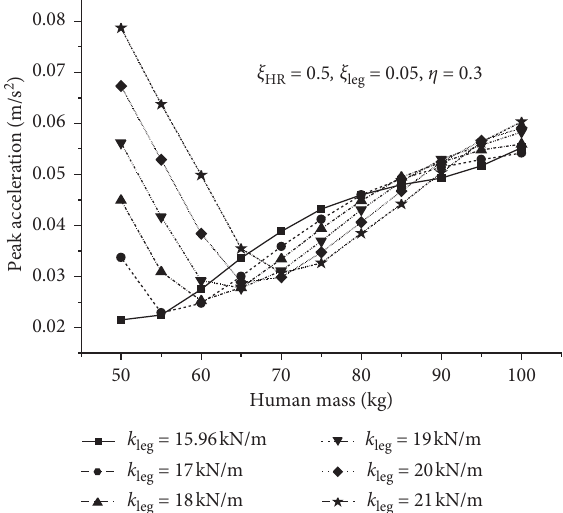
Figure 27: Peak acceleration under leg stiffness k � 0 . 5, and ξ � 0 . η � 0 . 3, ξ HR leg